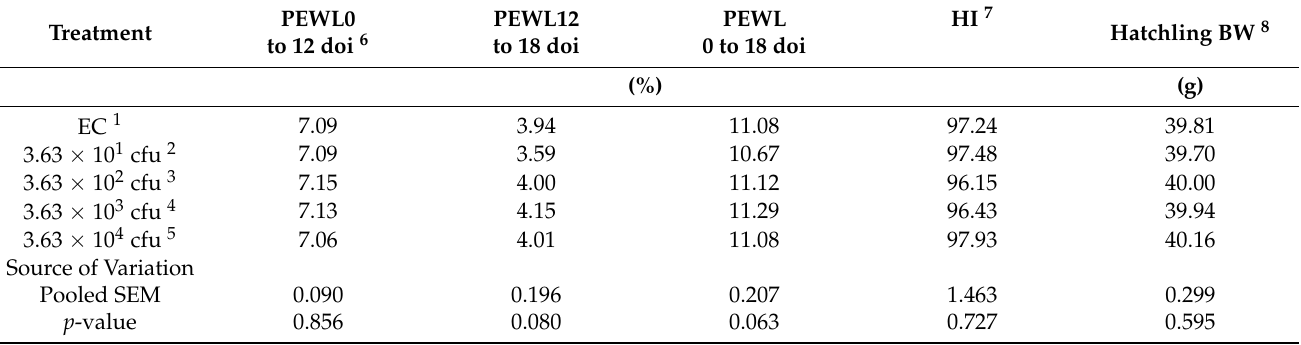
Table 2. Mean percentage egg weight loss (PEWL) in the 0 to 12, 12 to 18, and 0 to 18 days of incubation (doi) intervals, hatchability of injected eggs containing viable embryos (HI), and mean straight run hatchling BW at 22 doi in ts-11MG exposed diluent-injected control (EC) eggs and those